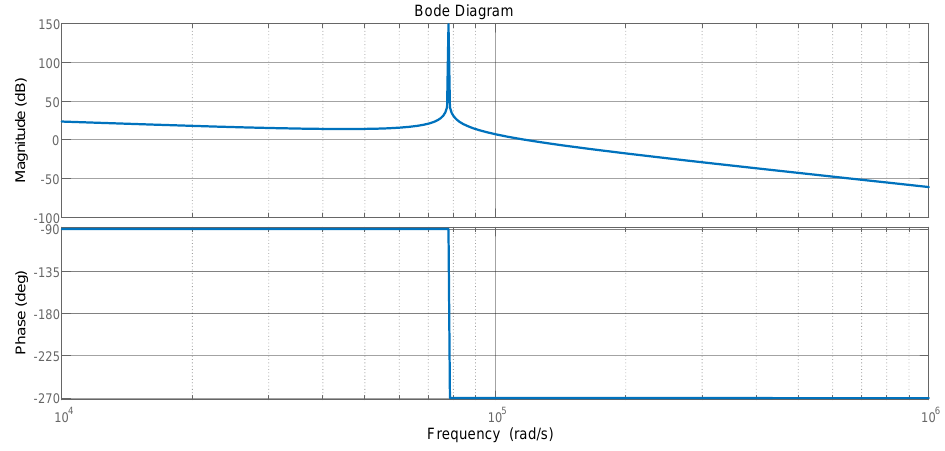
Figure 3. Frequency analysis of the designed LCL filter.